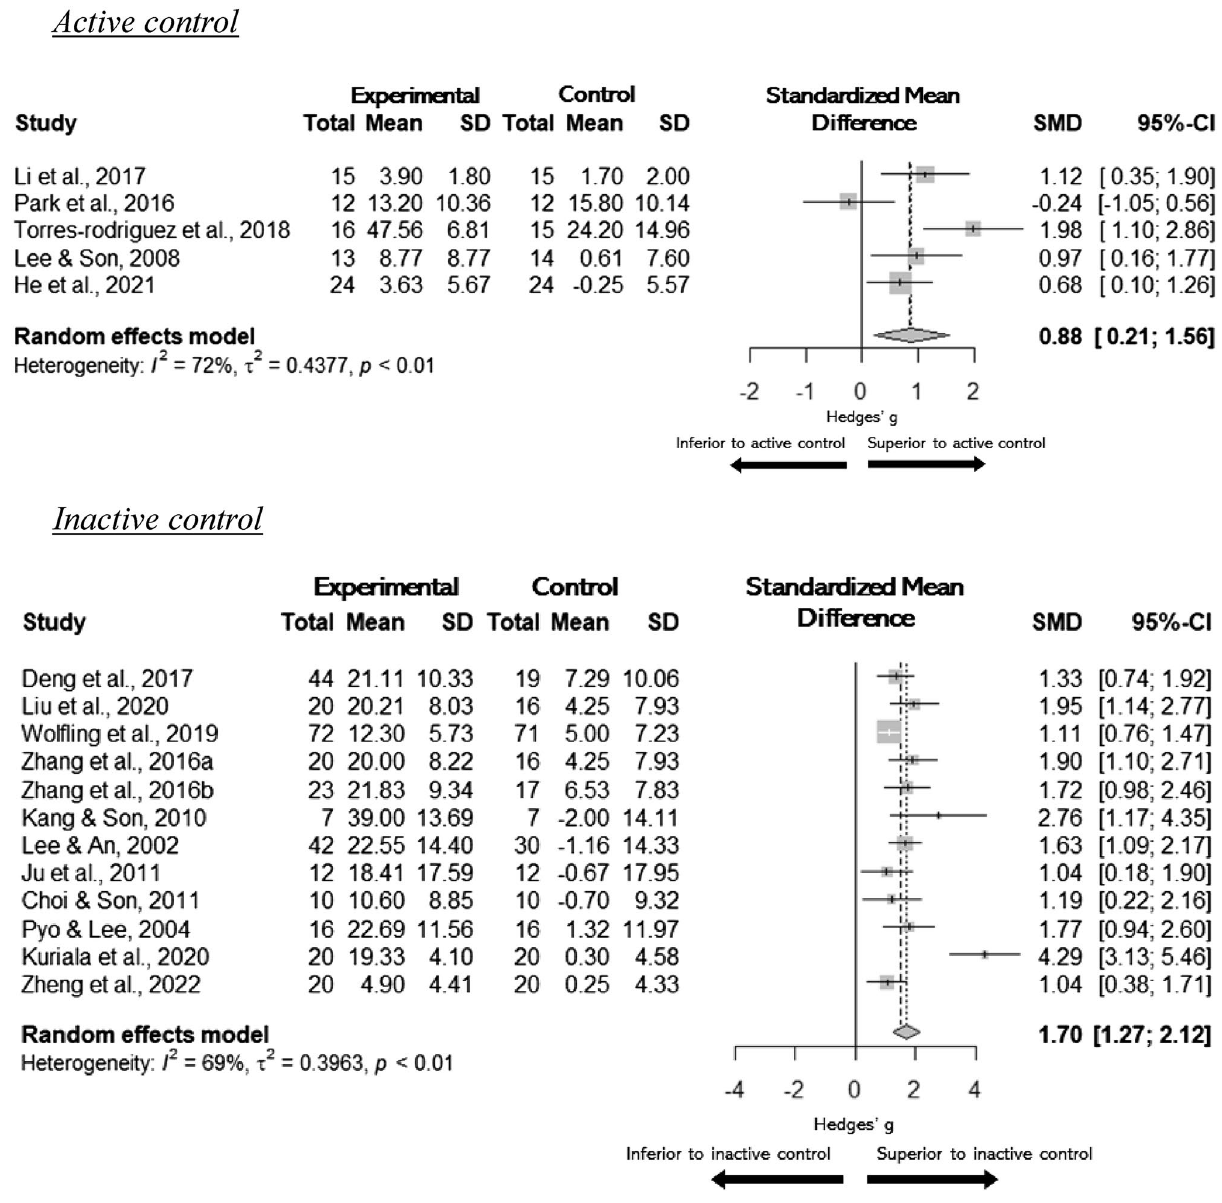
Figure 2. Pairwise Meta-analysis. Psychological treatment effects on excessive gaming by comparison group type (active and inactive controls). SMD standardized mean difference, SD standard deviation, CI confidence interval, I 2 = Higgins’ I 2